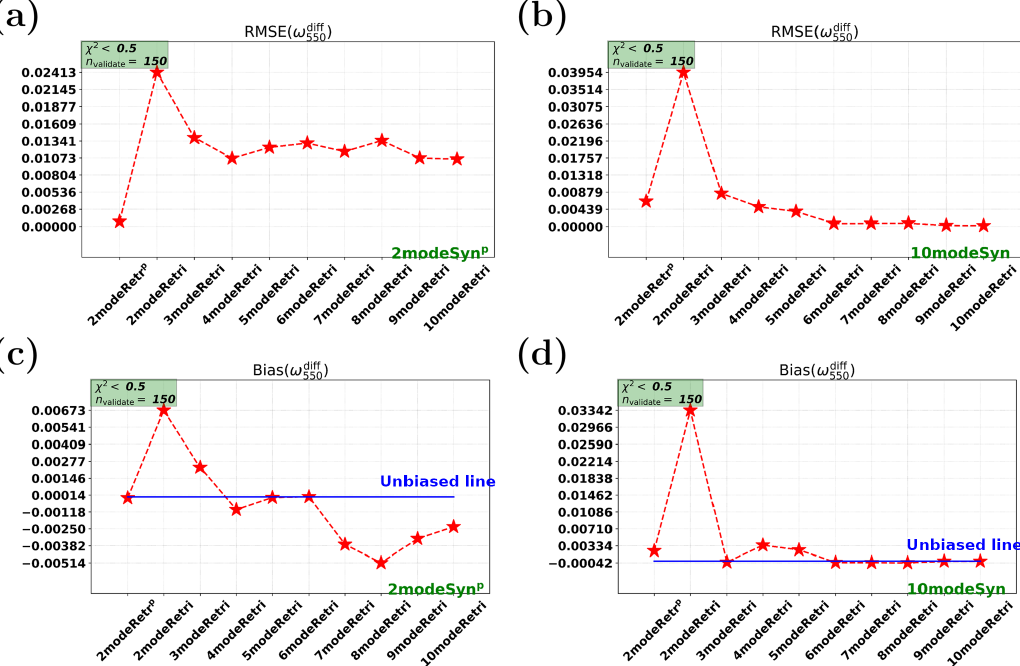
Figure 6. Synthetic retrievals for SSA: root-mean-square error (RMSE) and bias for the difference between the retrieved SSA and the true SSA. Panels (a, c) show RMSE and bias for the cases on 2modeSyn p . Panels (b, d) show RMSE and bias for the cases on